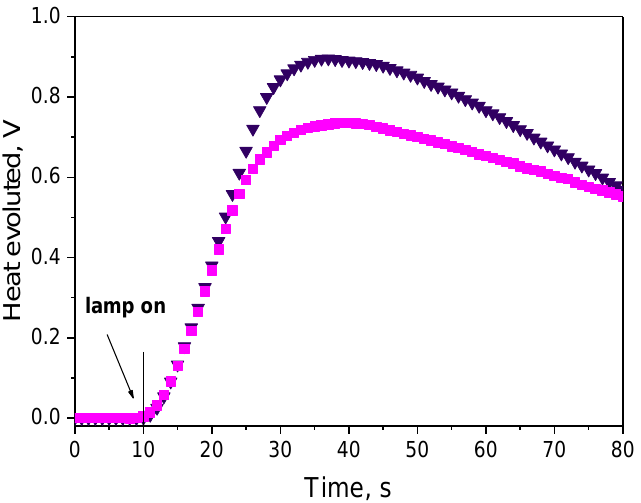
Figure 6. Comparison of the photoinitiation ability of the acenaphto[1,2-b]benzo[g]quinoxaline (AN6) to the camphorquinone (CQ). The tested photoinitiating systems possess the same co-initiator, (3,4-dimethoxyphenylthio)acetic acid (diMPhTAA), and different light absorber (sensitizer). The kinetic curves were recorded during the measurements of the heat flow emitted in the course of TMPTA polymerization photoinitiated by ■ —AN6–diMPhTAA and ▼ —CQ–diMPhTAA couples. The co-initiator concentration was 0.1 M, optical density of the sensitizers was 1.8 at an excitation wavelength (400 nm), light intensity of dental lamp was 30 mW/cm 2 .